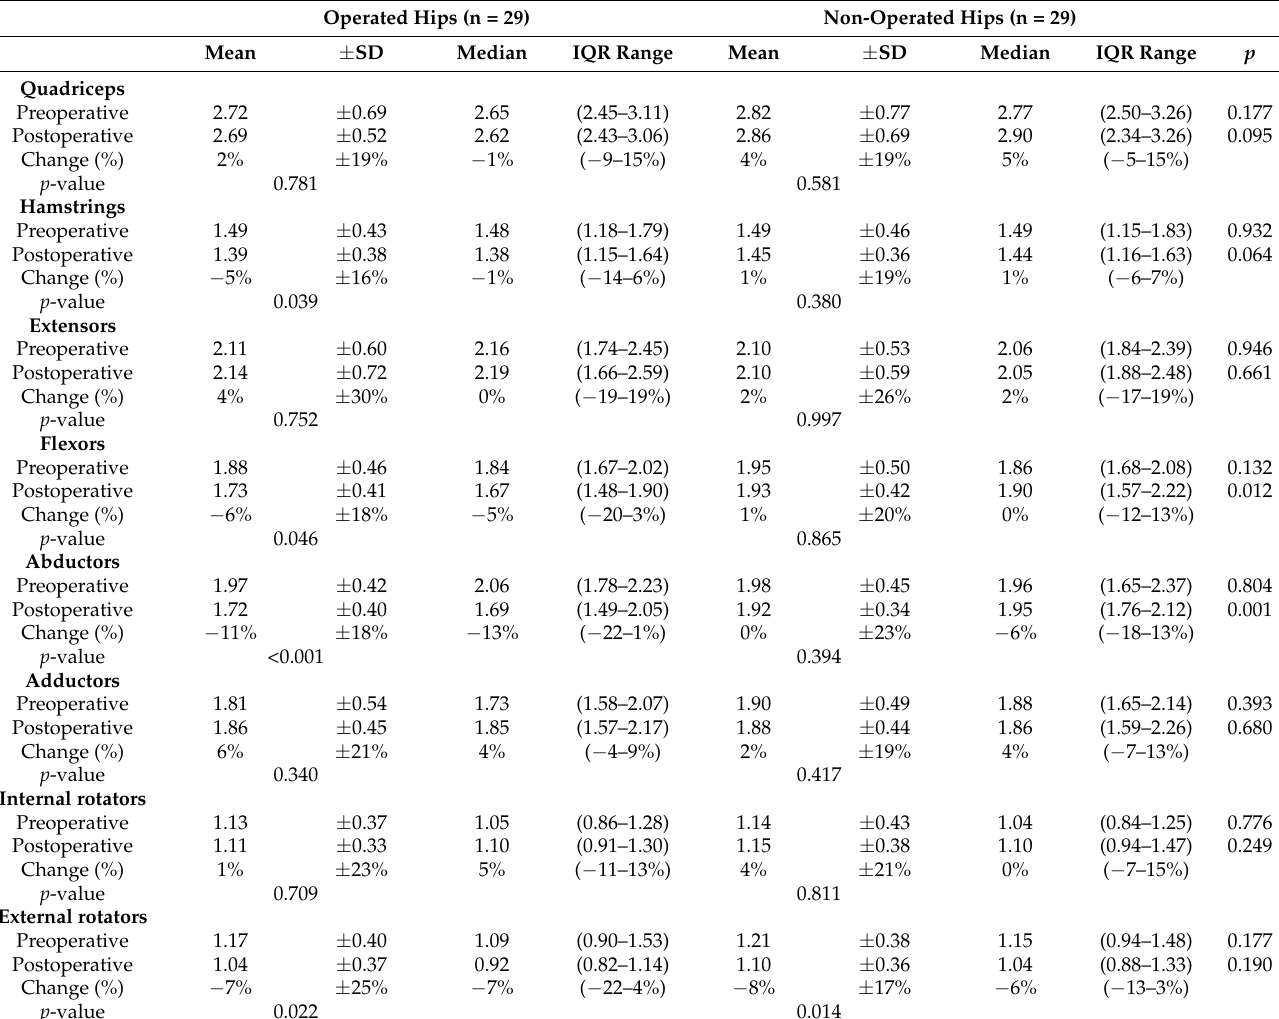
Table 1. Pre- and postoperative hip muscles strength (Nm/kg) for